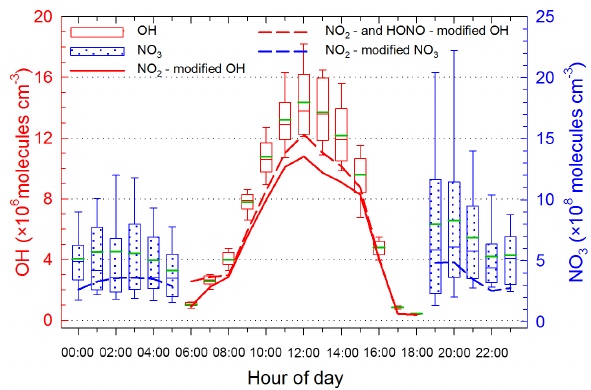
Figure 4. Box and whisker plots of average diurnal patterns of PBM-MCM modelled OH and NO 3 concentrations. The green thick line represents the mean value. Also shown are the results after con- ducting sensitivity analyses for the model by modifying the mixing ratios of NO 2 and